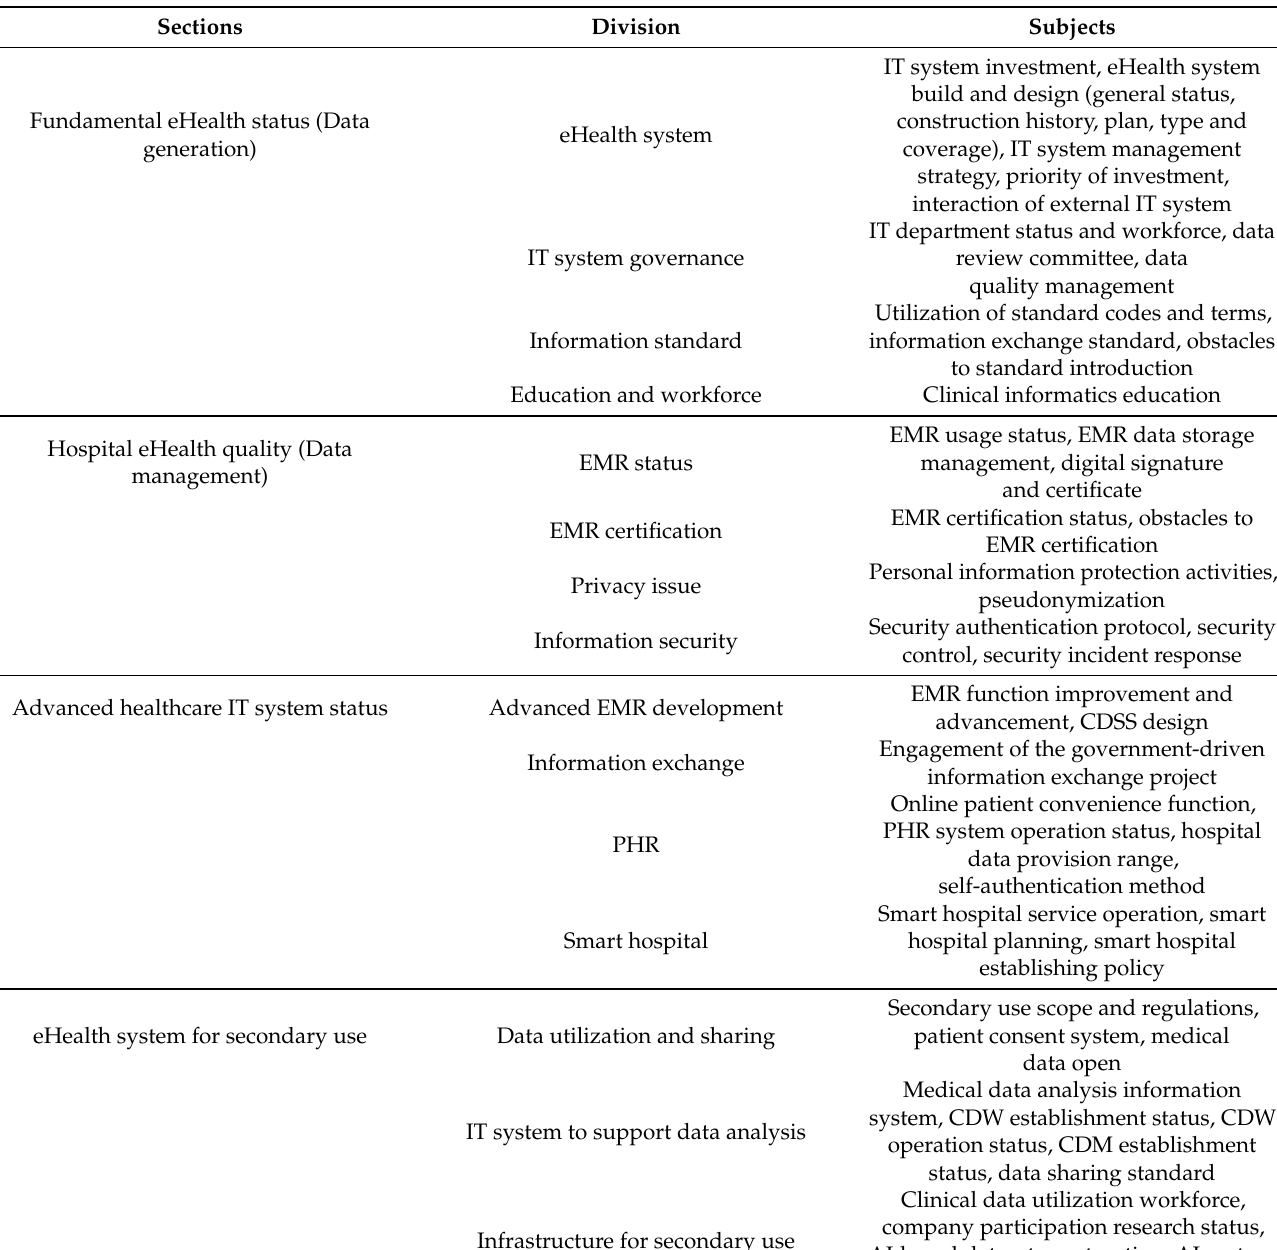
Table 1. EHealth 2020 National Profile Survey Items and